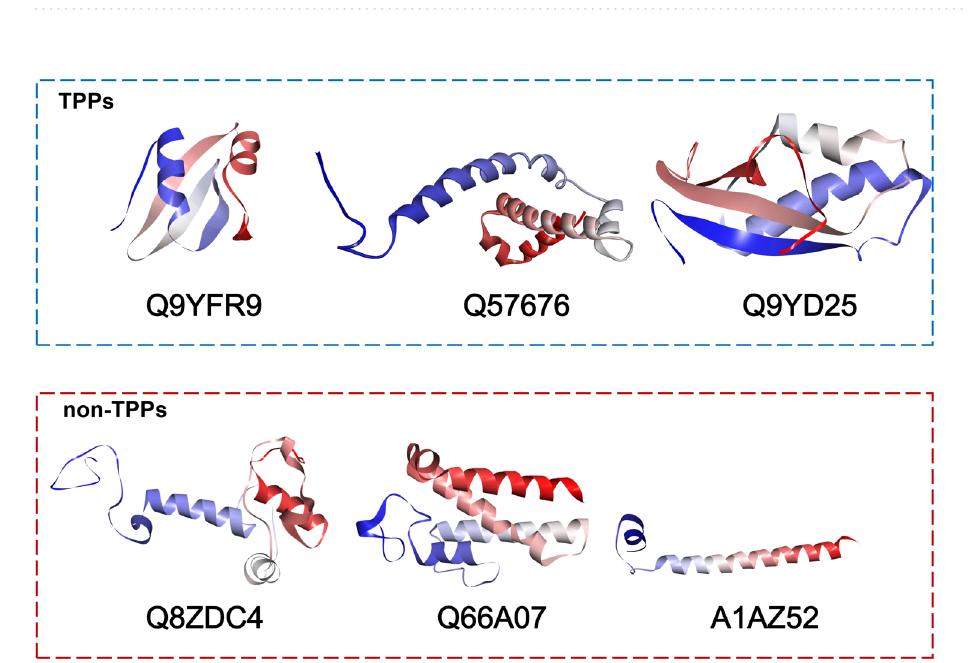
Figure 5. Three-dimensional structures of TPPs (Q9YFR9, Q57676 and Q9YD25) and non-TPPs (Q8ZDC4, Q66A07 and A1AZ52) having the highest (528.74, 527.79 and 525.29, respectively) and lowest (319.67, 331.20 and 340.61, respectively) TPP scores, respectively, where the optimal threshold value is